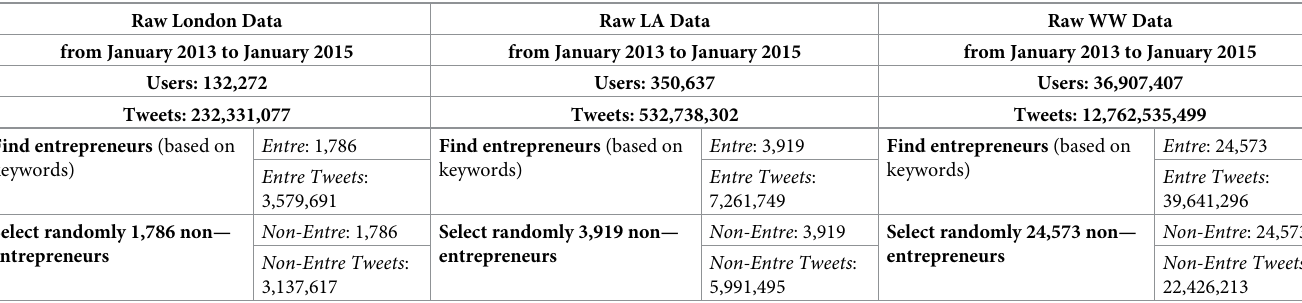
Table 1. Number of users, initial tweets, and usable tweets. Raw London